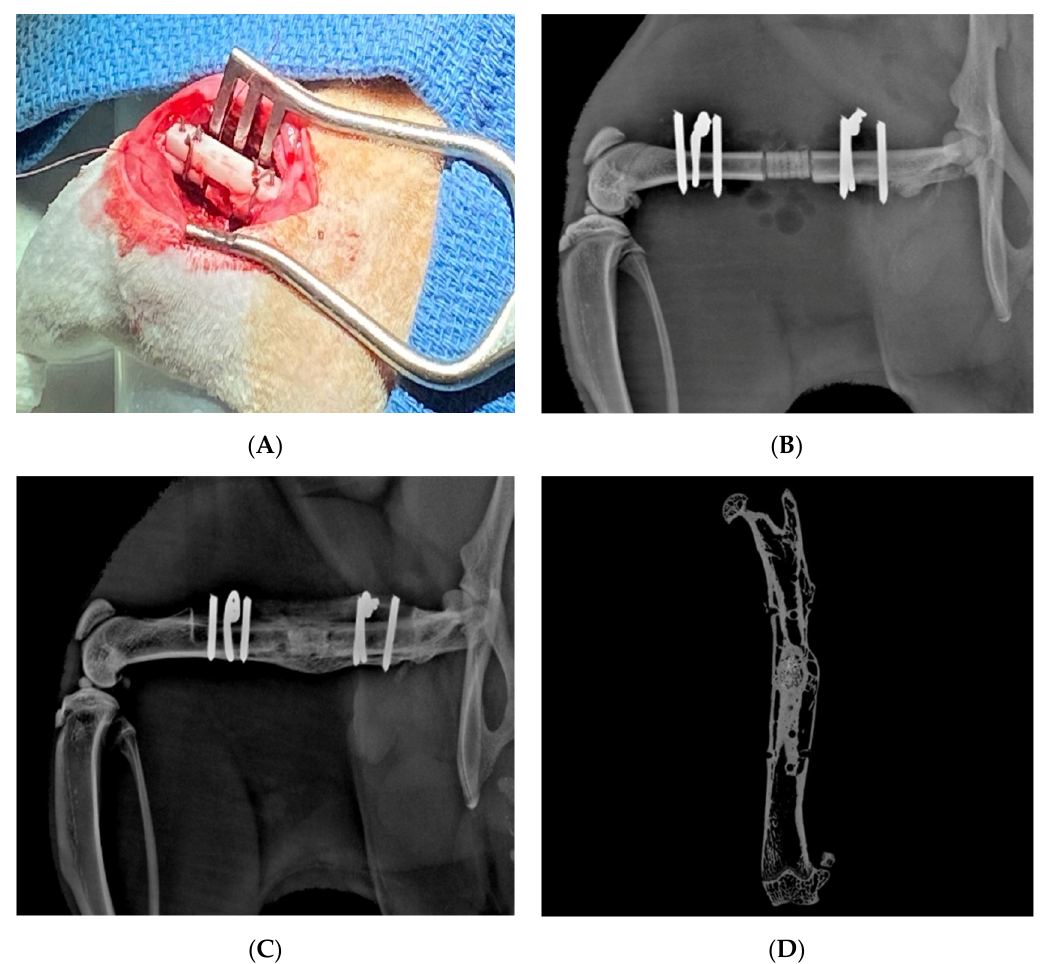
Figure 6. 3D printed hydroxyapatite/tricalcium phosphate scaffold loaded with LV-TSTA-BMP-2 transduced rat bone marrow stem cells. ( A ) Intra-operative implantation of the scaffold into a 6 mm femoral defect in a Lewis rat. ( B ) Lateral X-ray image of implanted scaffold on postoperative day 0. ( C ) Lateral X-ray and ( D ) MicroCT images taken at 24 weeks demonstrating healing of the defect and incorporation of the scaffold.